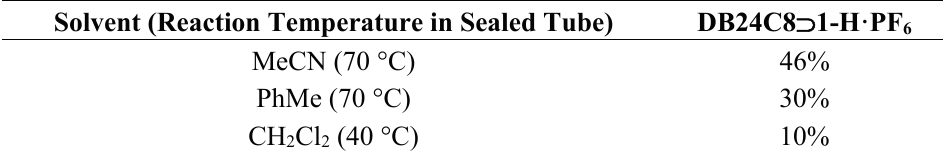
Table 1. Percentage yields of the [2]pseudorotaxanes after slippage reaction for 4 days. Analyzed by 1 H NMR spectroscopy (400 MHz, 298